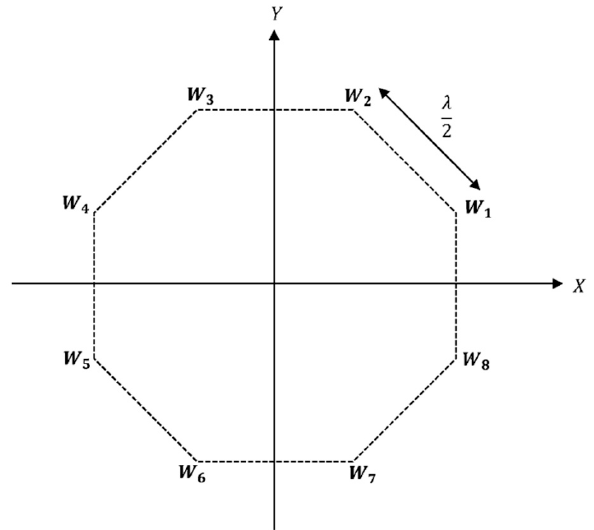
Figure 3. Schematic Diagram of the Proposed Regular Octagonal Configuration.